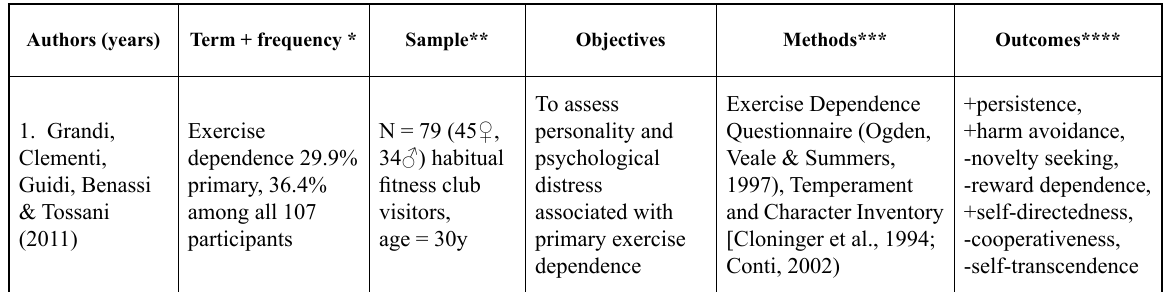
Table 2. Summary of the one study between 1995 and 2016 investigating the relationship between exercise addiction and